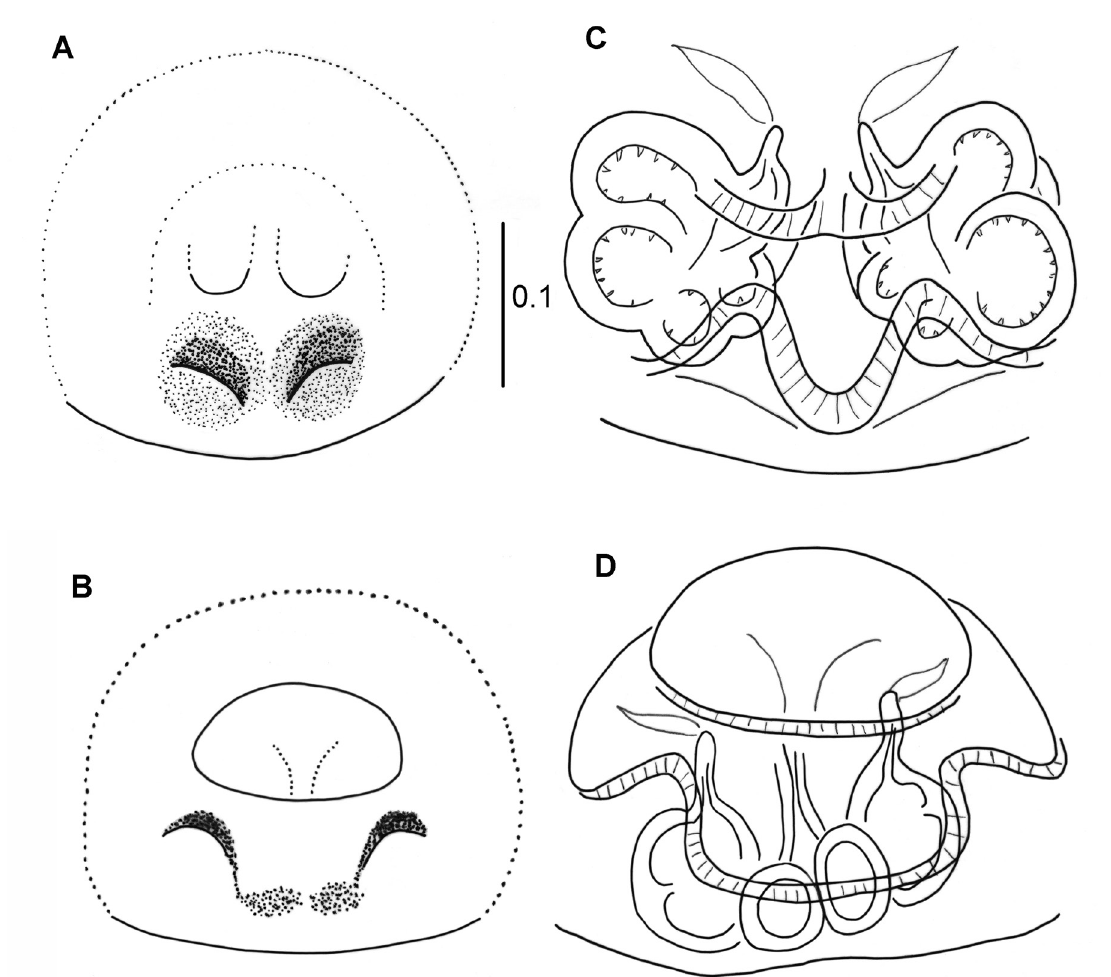
Fig. 10. Baryphas jullieni Simon, 1902, ♀ (MNHN). A–B . Epigyne. C–D . Internal structure of